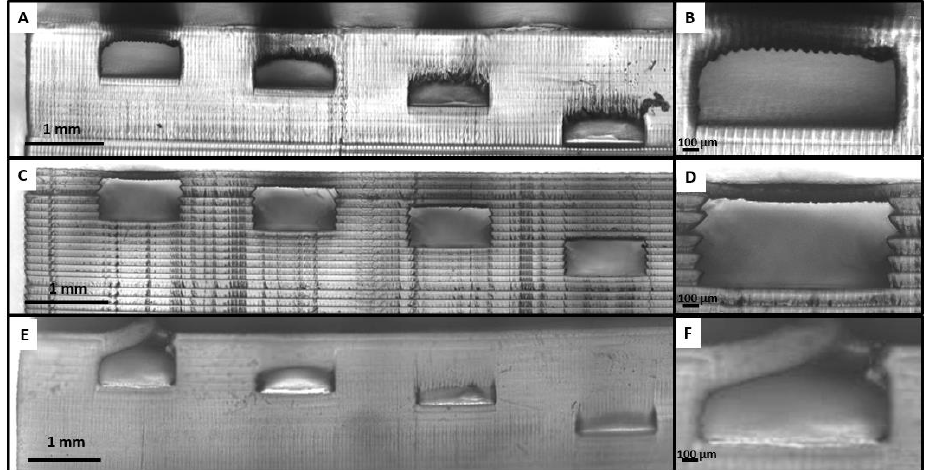
Figure 10. Pictures of the 3D printed closed channels using Detax ( A ), Asiga ( C ), and Keyprint ( E ) resins. All the structures in ( A , C , E ) consist of four channels of 1 mm width and 500 µm height with a different number of layers in the cover of the channel (1, 2, 4, 8 layers of 100 µm each from left to right). A zoomed view of the channel with a cover of 100 µm printed can be also seen with the Detax ( B ), the Asiga ( D ), and the Keyprint ( F ) resins.